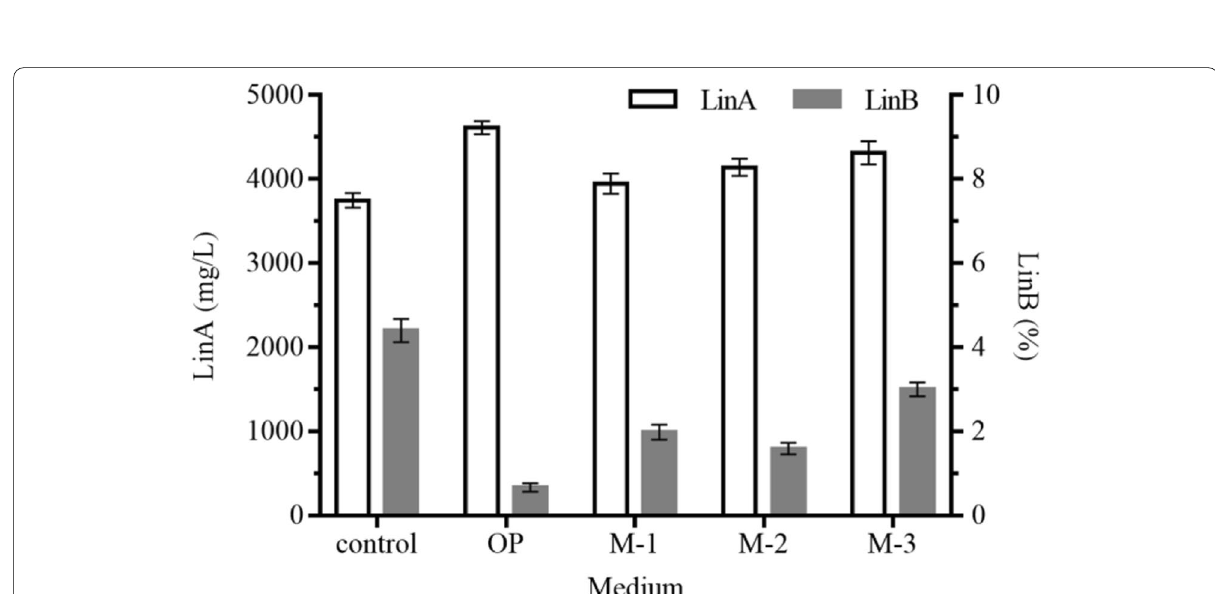
Fig. 4 Effects of different media on lincomycin A yield and lincomycin B concentration. Control: initial medium. The experimental media included the same components as the initial medium except for the following differences: OP: optimized medium and 1.4 g/L corn steep liquor and 126 g/L glucose; M‑1: 10 g/L NaCl; M‑2: 126 g/L glucose; and M‑3: 1.4 g/L corn steep